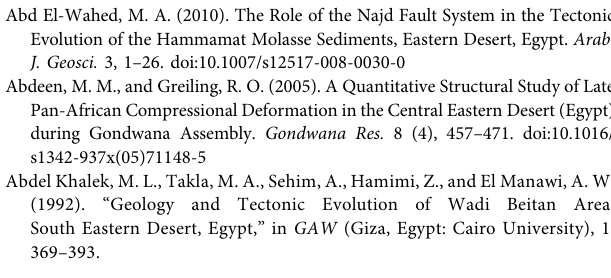
RGB(PC2,PC4,PC5)oflandsat-8OLIwhichrepresentsthegeographicdistribution of serpentinites, ophiolitic metagabbros, ma fi c and arc metavolcanics and volcaniclastic metasediments in the Egyptian Nubian shield. (B) Gneisses and granitoid rocks mapped using the processed false color composite (RGB-753) of Landsat-8 OLI which showed the distribution of the gneisses rock in the